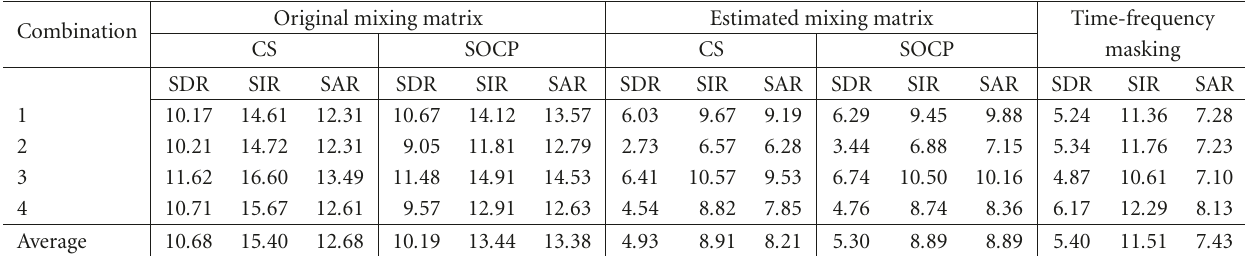
Table 2: Separation results for 3 sources (3, 5, 7), 2 mixtures (1, 2).